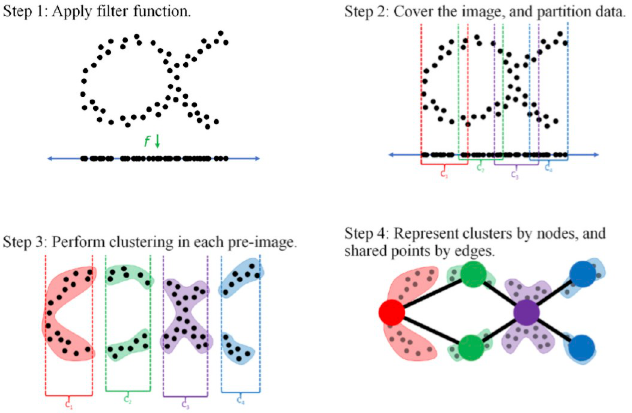
Fig 1. An illustration of the Mapper algorithm. Image Source: Escolar, Hiraoka, Igami, Ozcan [4].